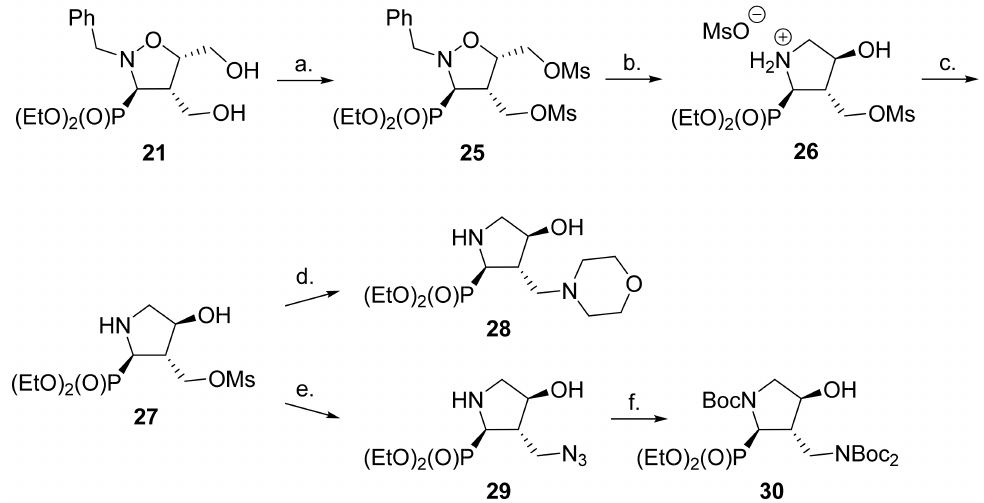
Scheme 5. Synthesis of functionalized proline analogues 28 and 30 . Reaction and conditions: a. MsCl, Et 3 N, CH 2 Cl 2 , 0 ◦ C, 2h, 96%; b. H 2 , Pd(OH) 2 –C, MeOH, 1.01 bar, 22 h or H 2 , Pd(OH) 2 –C,